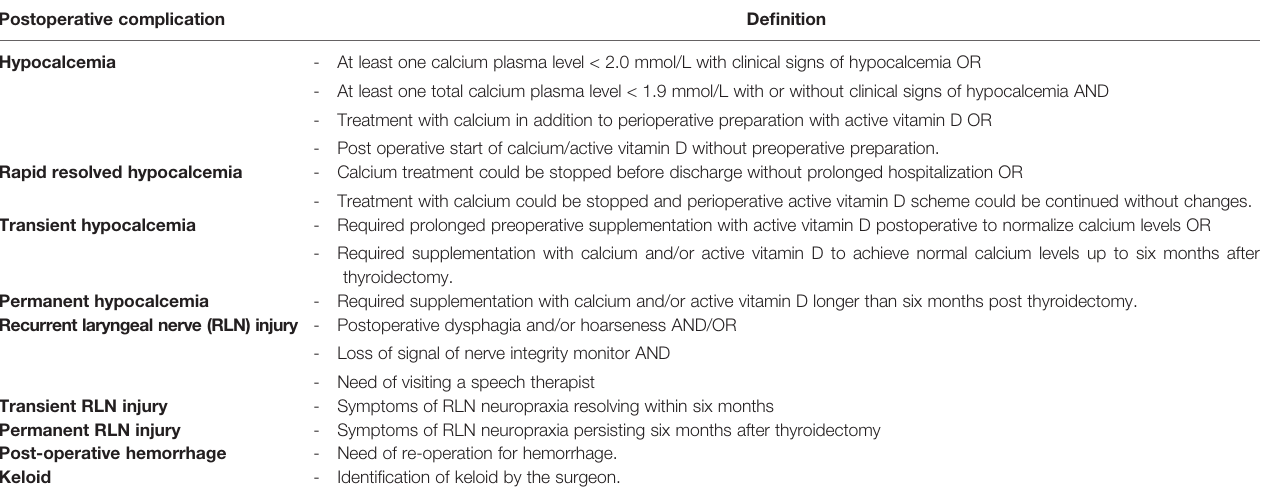
TABLE 1 | De fi nitions used for the different postoperative complications evaluated in pediatric patients after